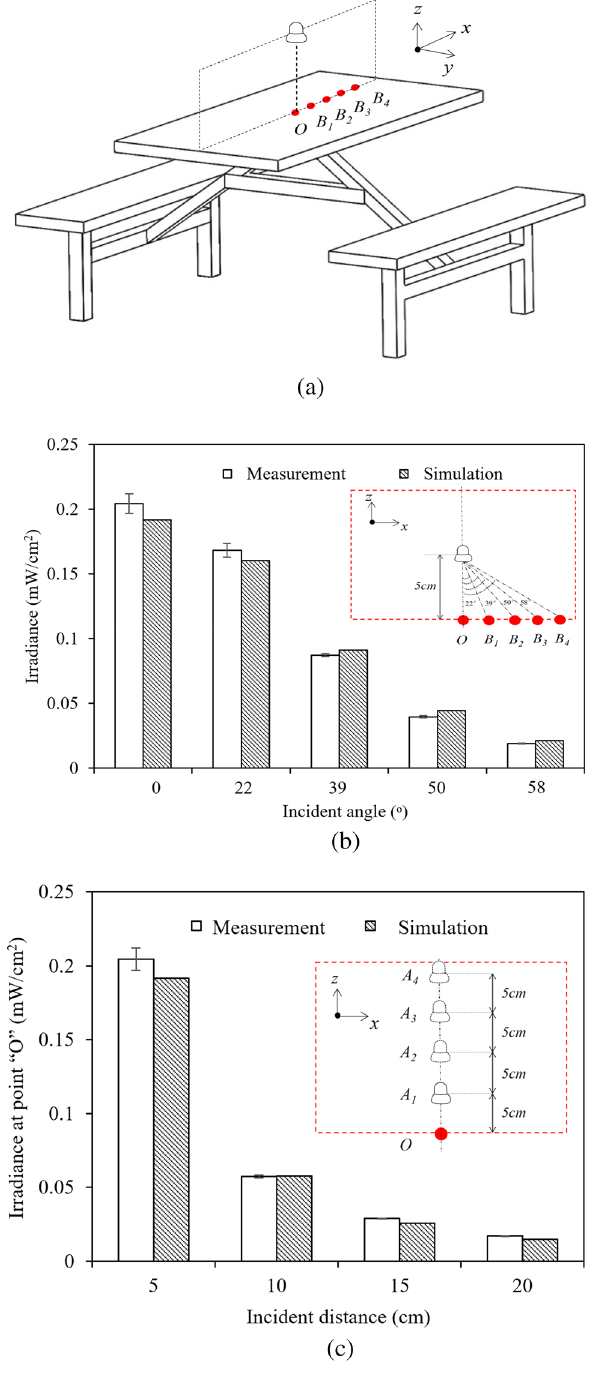
Figure 2. Comparison between the predicted and measured irradiance on the dining-table surface: ( a ) Schematics of far-UVC irradiance sampling positions; ( b ) irradiance versus incident angle; ( c ) irradiance versus incident